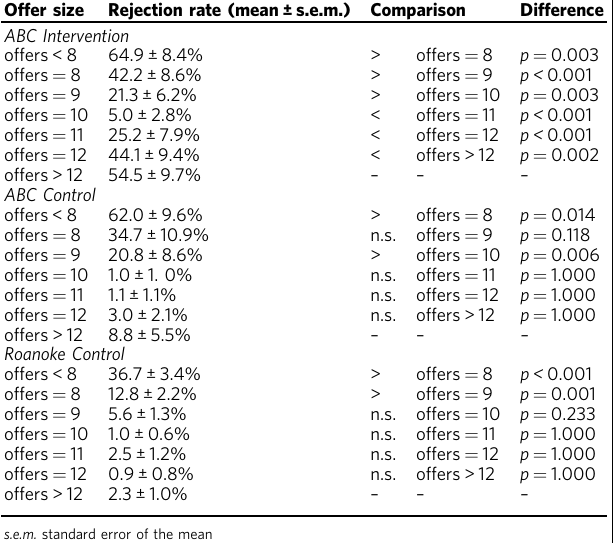
Table 2 Rejection rates between offer sizes in Medium- High-Medium conditioning